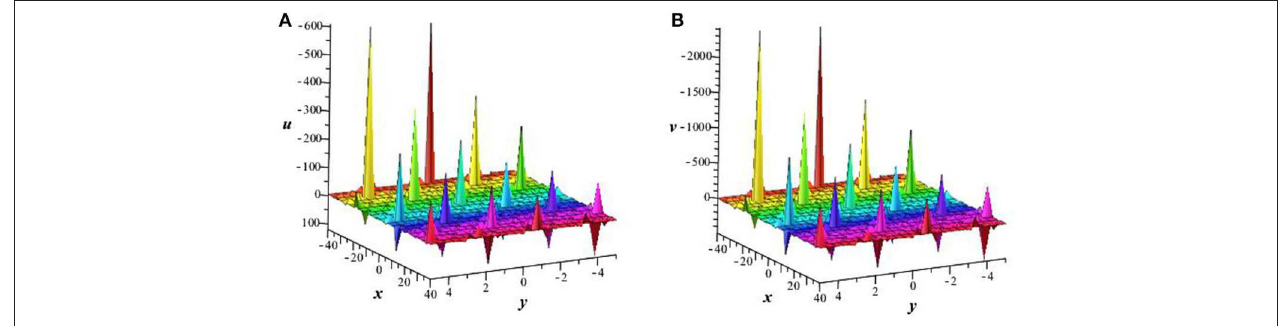
sint , A 1 k 1 β 1, B 1 4, α 1, k 2 3 at t 0. (A) Perspective view of the solution u . (B) Perspective = = = = = = = =